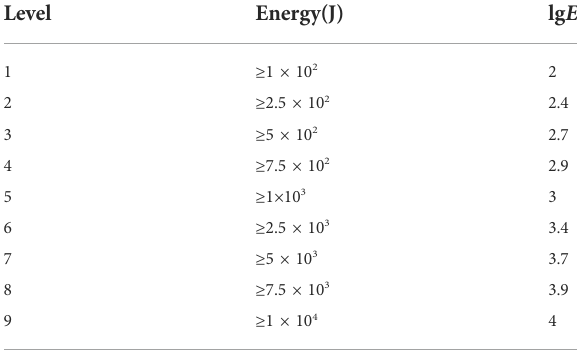
TABLE 2 Division of energy levels for microseismic events.